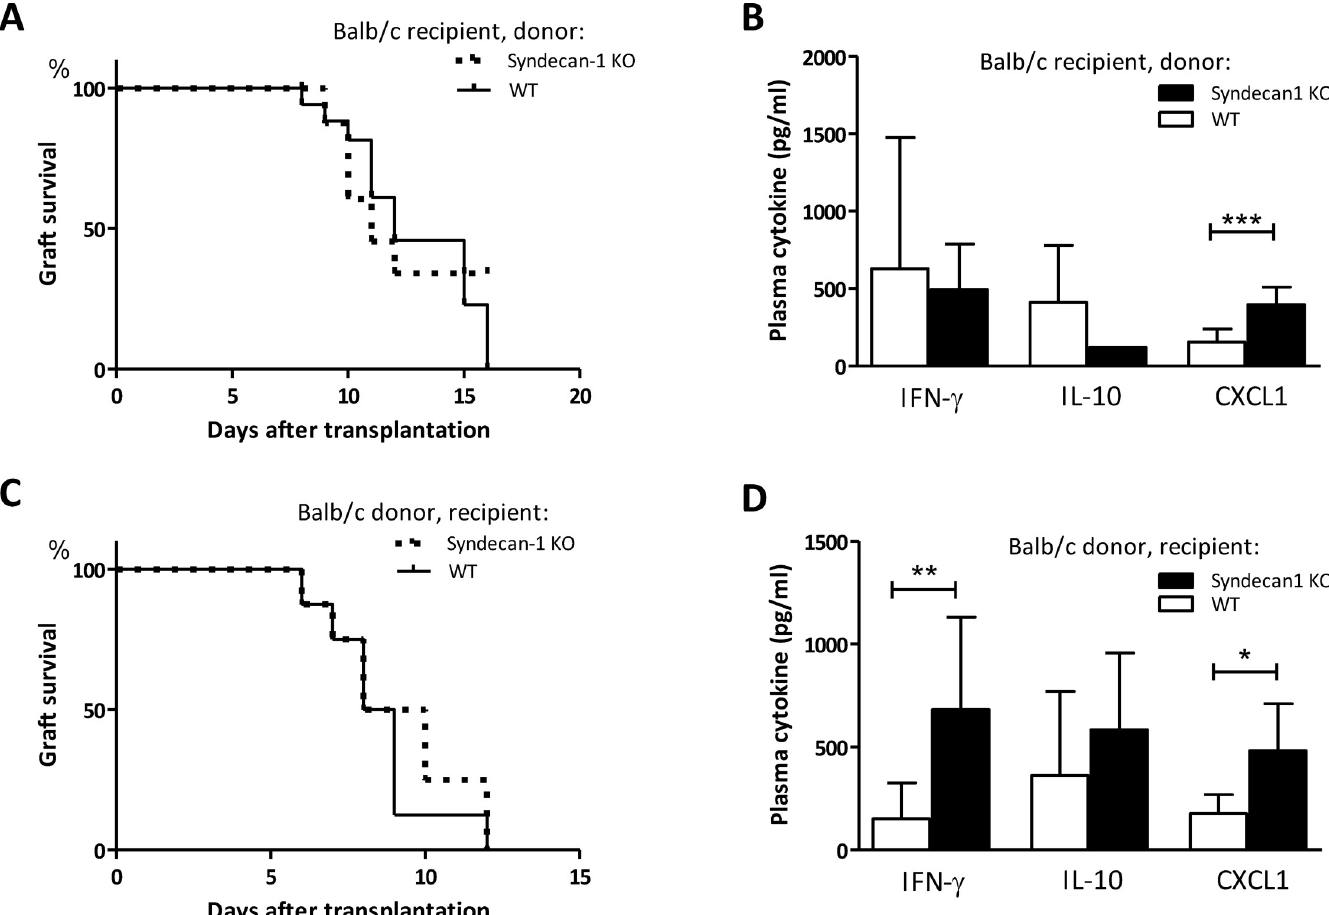
Fig 4. Sdc-1 deficiency affects cytokine levels in allograft recipients without affecting allograft survival. Allograft survival in a fully mismatched heterotopic heart transplantation model. Hearts were obtained from Sdc-1-deficient (n = 9) or WT mice (n = 8) and transplanted in Balb/c mice (A). Plasma cytokine levels in Balb/c recipient mice that received WT or Sdc-1 deficient hearts (B). Allograft survival of Balb/c hearts in WT (n = 8) or Sdc1-deficient (n = 8) recipients (C). Plasma cytokine levels in WT or Sdc-1 deficient recipients that received a Balb/c heart (D). � p < 0.05, �� p < 0.01, ��� p < 0.001, Mann Whitney test.